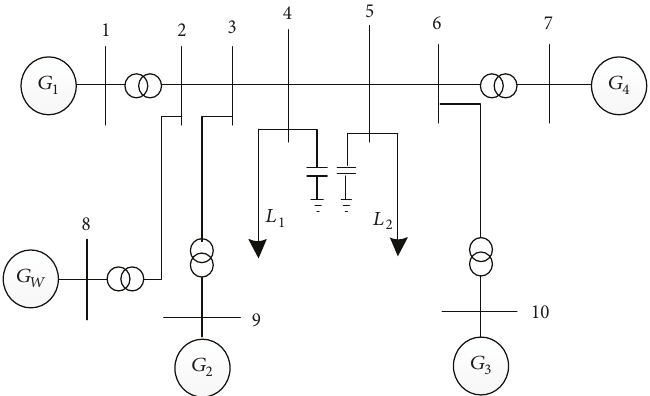
Figure 5: The structure of 2-area test system.